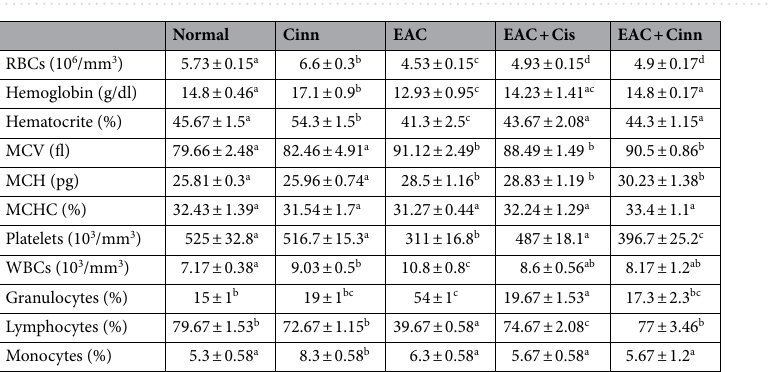
Table 4. The effect of Cinn oil treatment on the hematological changes in EAC-bearing mice. Data were showen as mean ± SD ( n = 3). Significant differences ( P < 0.05) between groups were shown by different letters. EAC, Ehrlich ascites carcinoma; Cis, Cisplatin (2 mg/kg b.wt, i.p); Cinn, Cinnamon essential oil (50 mg/ kg b.wt/day, orally); RBCs, red blood corpuscles; MCV, mean corpuscular volume; MCH, mean corpuscular hemoglobin; MCHC, mean corpuscular hemoglobin concentration; WBCs, white blood cells.